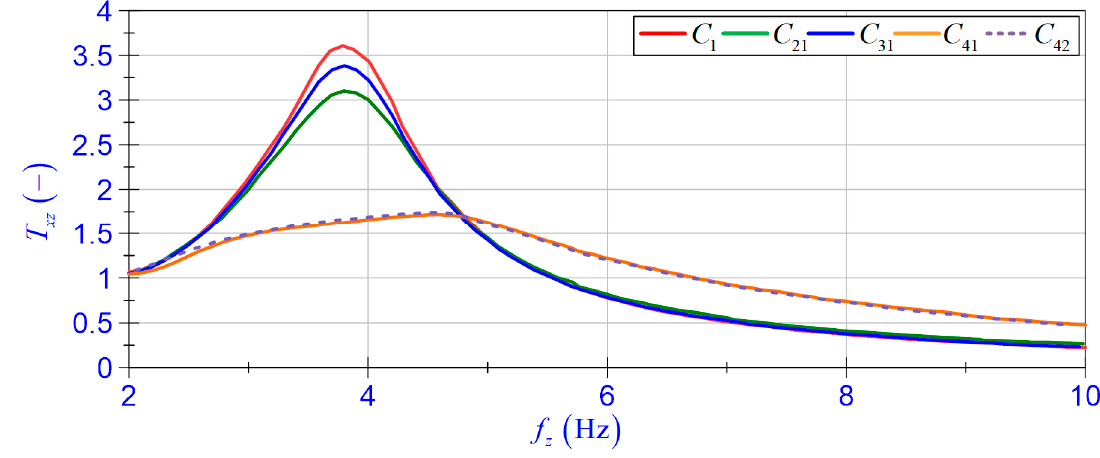
Figure 7. Displacement transmissibility T xz vs. frequency f z .